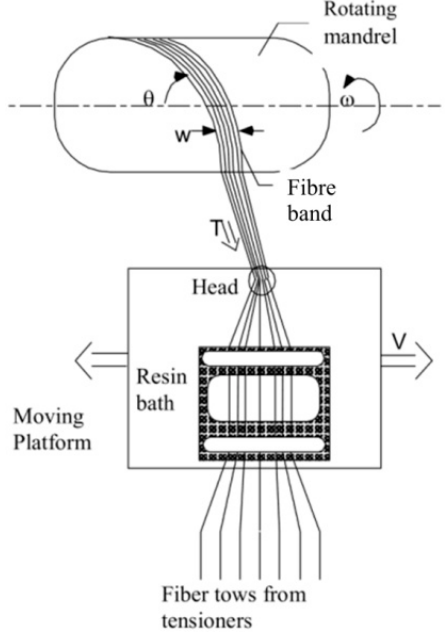
Figure 29. Schematic diagram of the filament winding process (reproduced with permission from [363]; copyright© 2021 Elsevier Science Ltd.).